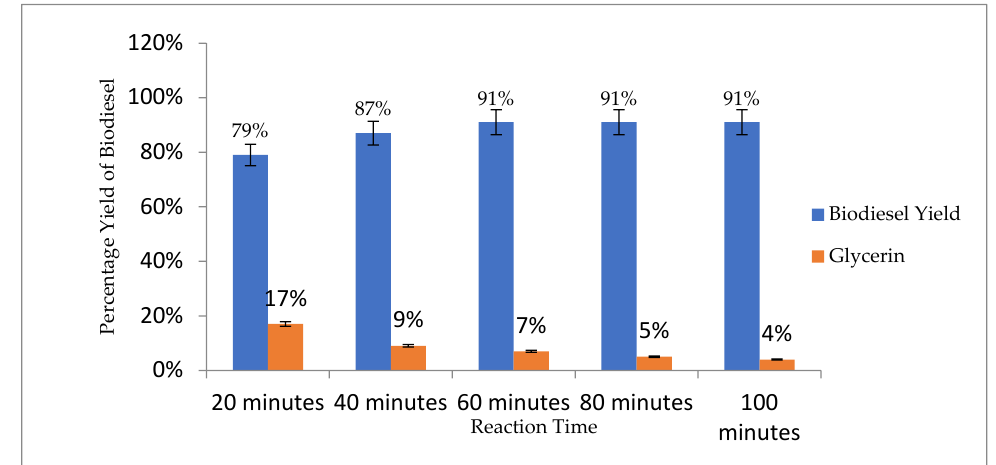
Figure 6. The influence of reaction time on biodiesel yield and on glycerin formation reduction.